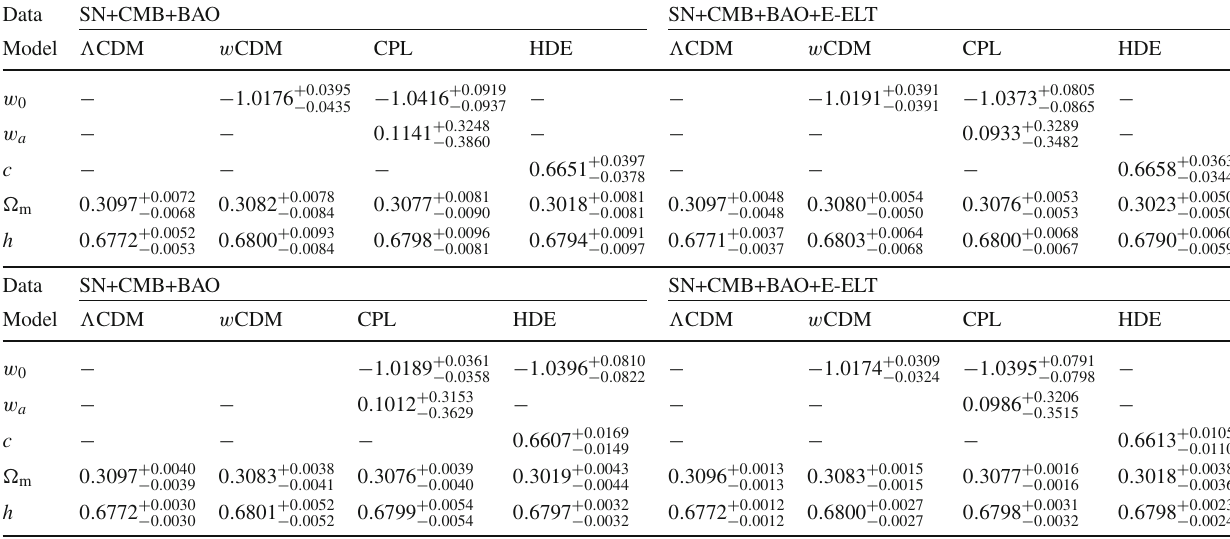
Table 3 Fitting results of parameters in the (cid:2) CDM, w CDM, CPL, and HDE models using SN+CMB+BAO, SN+CMB+BAO+E-ELT,